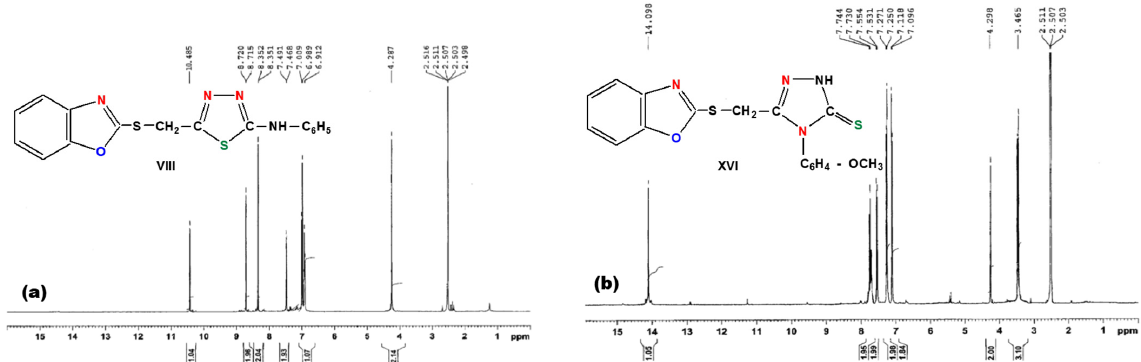
Figure 7. FT-IR spectrum of ( a ) 1,3,4-thiadiazoles (compound VIII) and ( b ) 1,2,4-triazole (compound XVI).